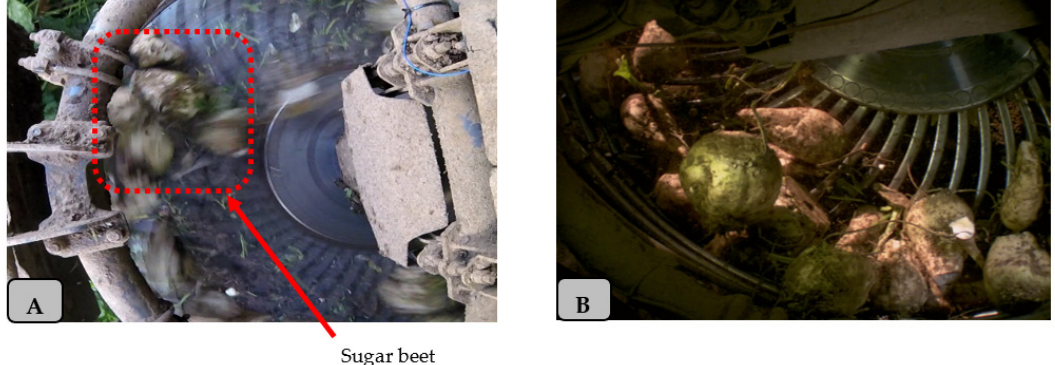
Figure 2. Example of sugar beet images in the cleaning unit using normal ( A ) and high speed ( B ) cameras in the sugar beet harvester.